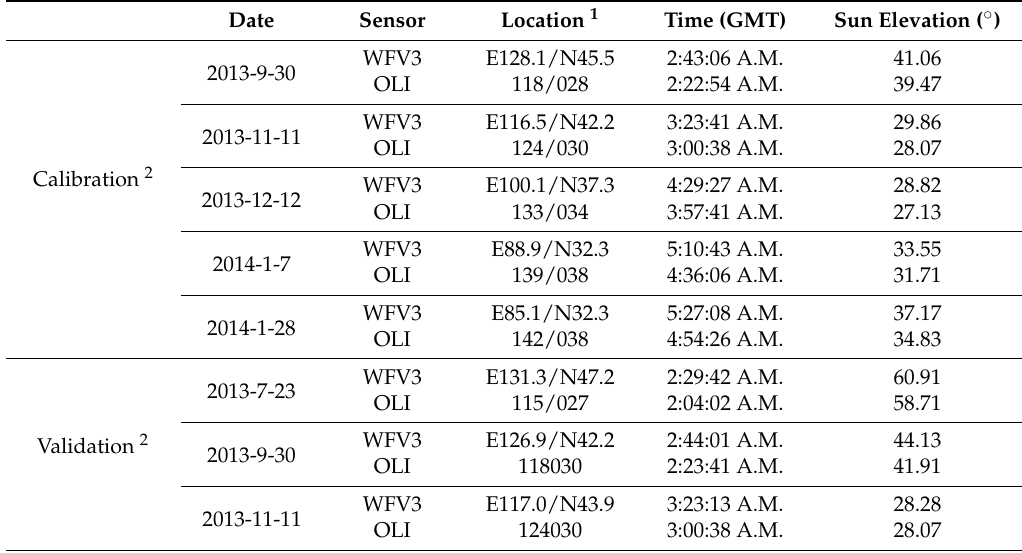
Table 2. Gaofen-1 WFV3 and Landsat-8 OLI image pairs used in this